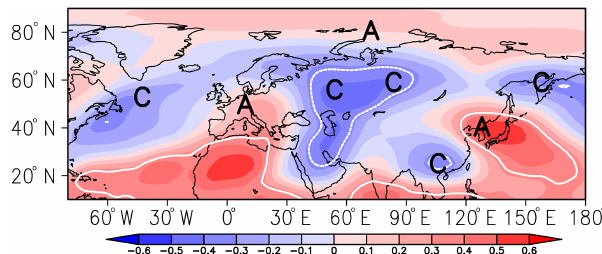
Figure 11. The CC between predictor x 5 ( ×− 1) and Z500 DY in winter from 1980 to 2013. The white curves indicate that the CC exceeded the 95% confidence level. A and C represent anticyclone and cyclone, respectively.